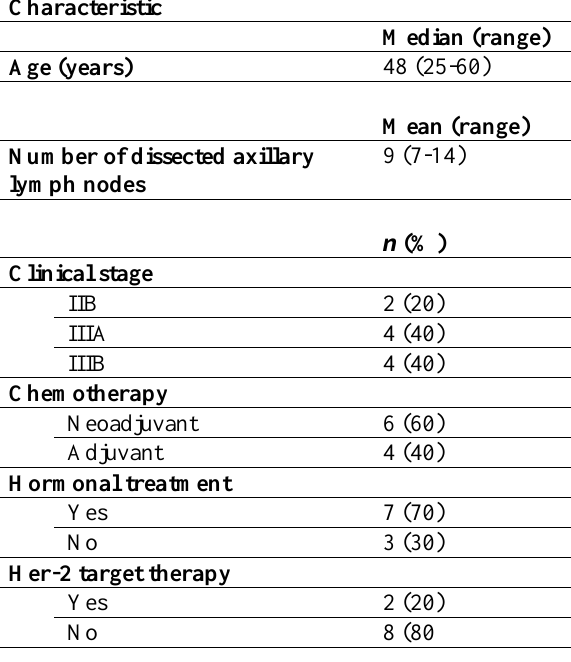
Table 2: Clinicaopathological characteristics